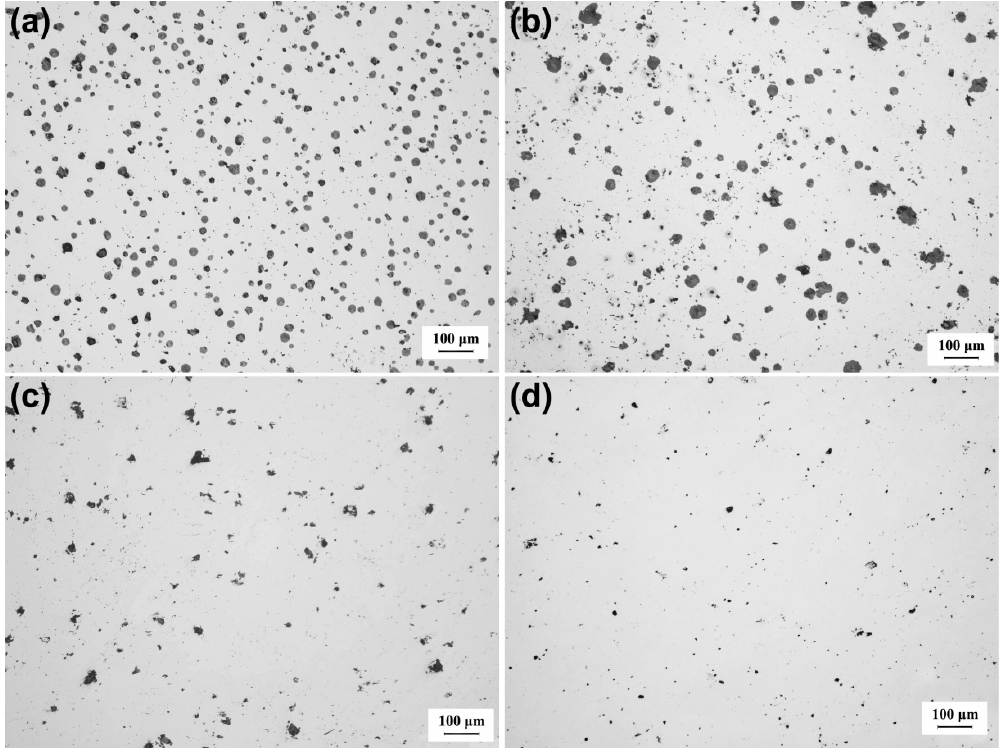
Figure 2. Graphite nodule morphology (unetched) of DI after injecting nitrogen gas for different time periods: ( a ) 0 min; ( b ) 20 min; ( c ) 40 min; ( d ) 60 min.